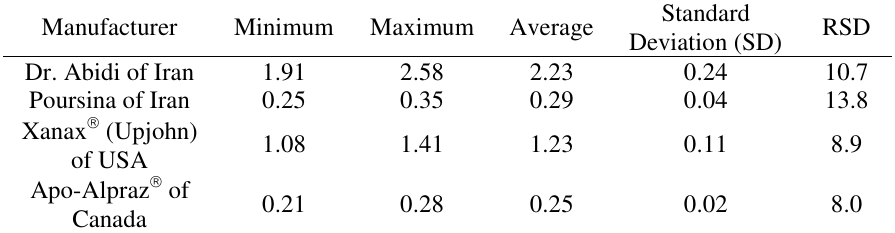
Table 3 . Results obtained from disintegration time measurement (min)